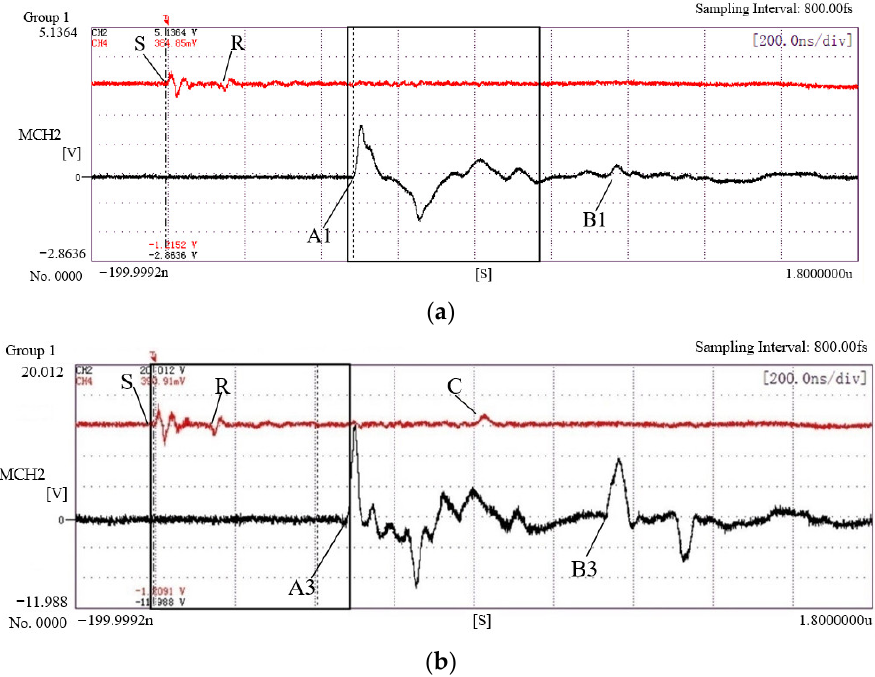
Figure 12. Dynamic strain characteristics of E690 high-strength steel under laser shock loading at power densities of ( a ) 1.53 GW/cm 2 and ( b ) 4.07GW/cm 2 .